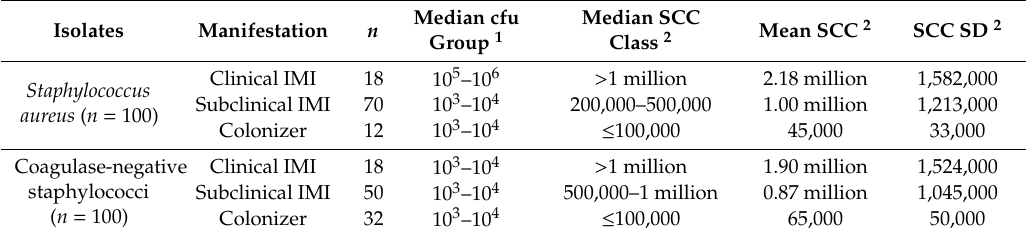
Table 1. Staphylococcus aureus and coagulase-negative staphylococci assigned to three different presentations including range and mean somatic cell count and colony forming units in quarter milk